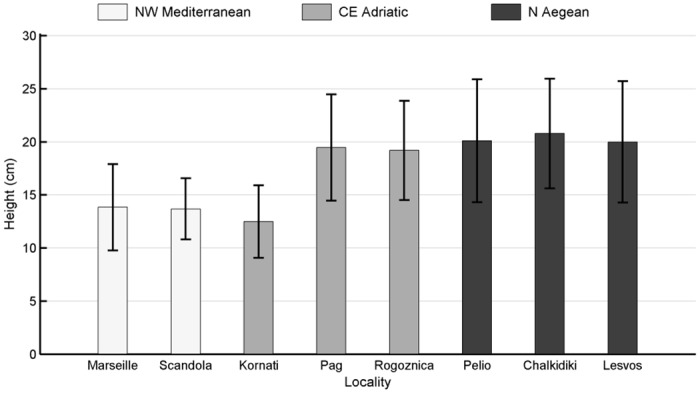
Mean height of Eunicella cavolini colonies per locality.Whisker span indicates standard deviation. Colors denote geographic regions.